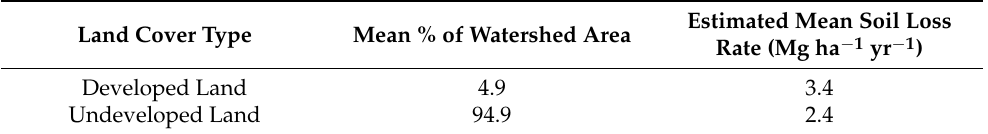
Table 10. Area Percentage and estimated area-weighted mean soil loss rate of Developed Land and Undeveloped